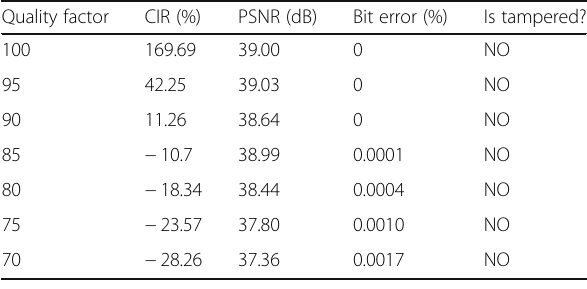
Table 1 Different quality factors for stadium